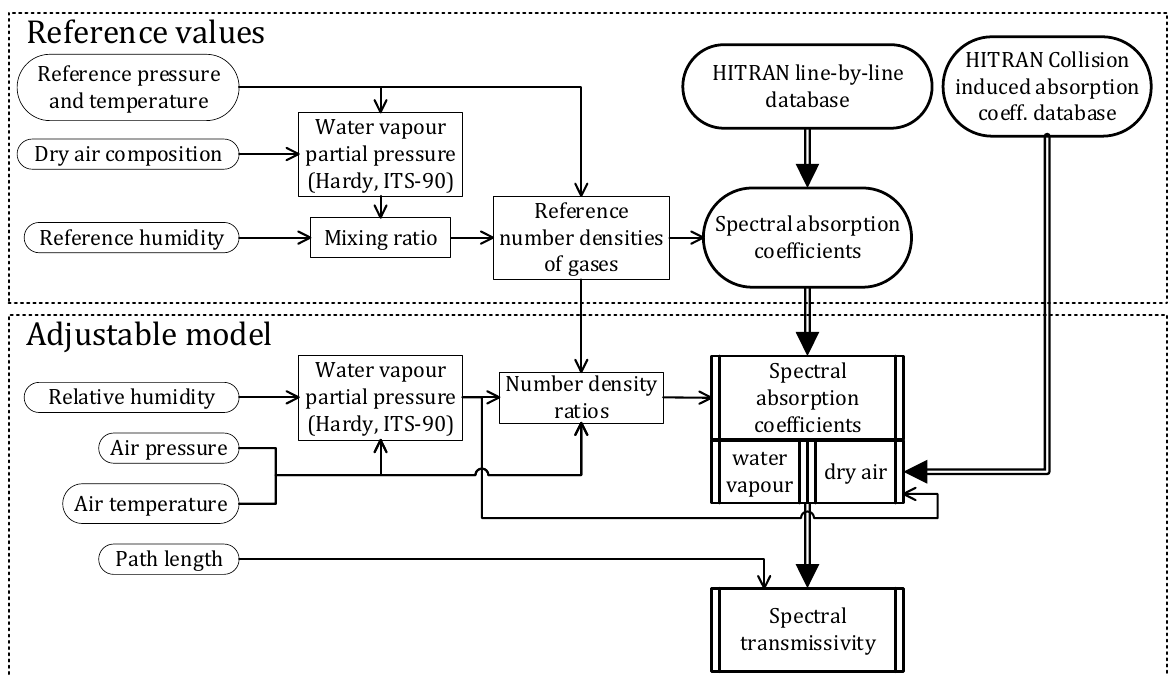
Figure 2. Flow chart of air transmissivity calculation algorithm.